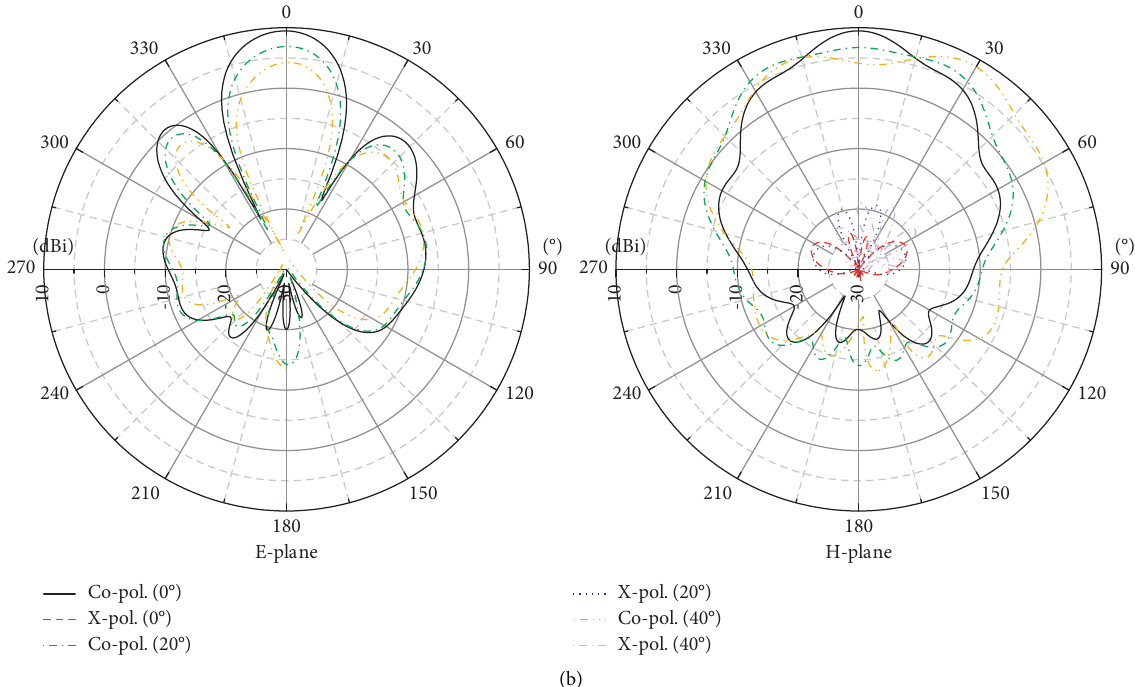
Figure 19: Patterns of the (a) 4 × 1 subarray and (b) 4 × 4 patch array under different folding angles.